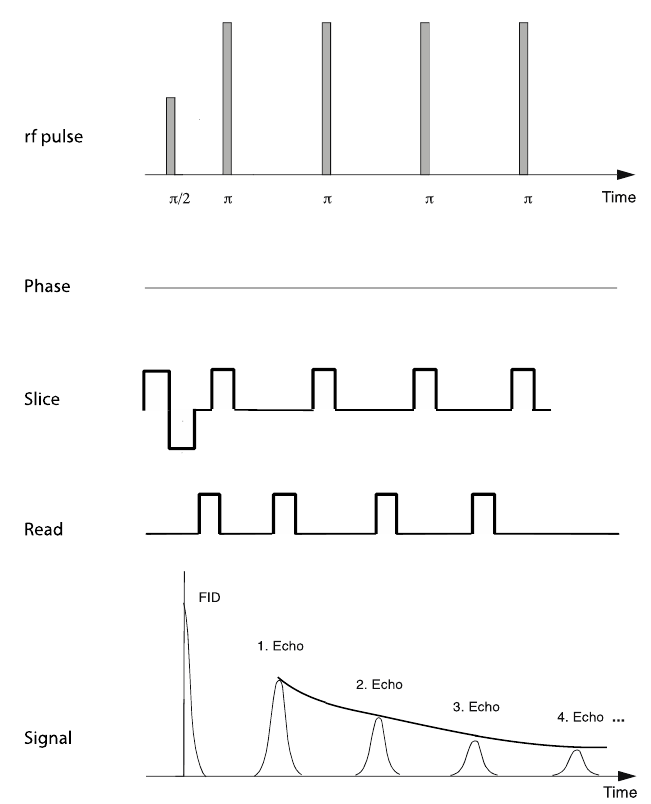
Figure 2. An MSME imaging sequence (simplified; for further detail see [28]). Read, phase and slice refer to the transient gradients that are superimposed on the main magnetic field to achieve spatial resolution. The relaxation time T intensity at the echo-times following each refocusing pulse ( 